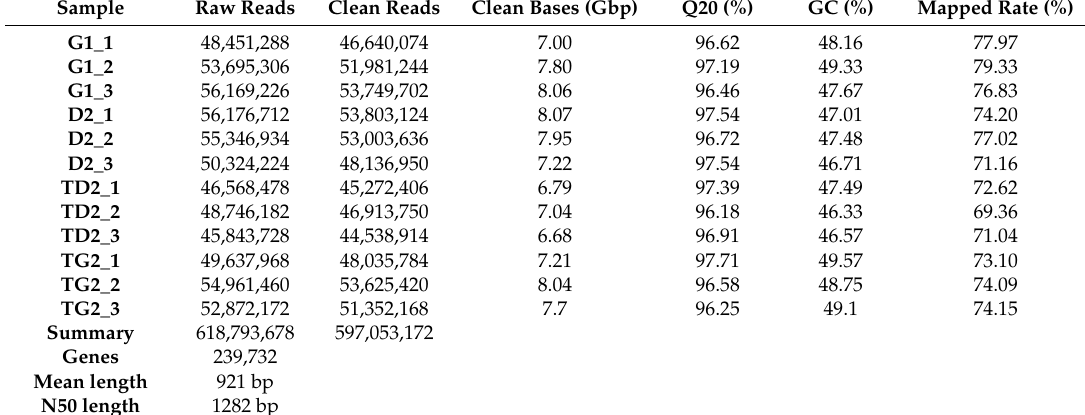
Table 1. Summary of sequences analysis.